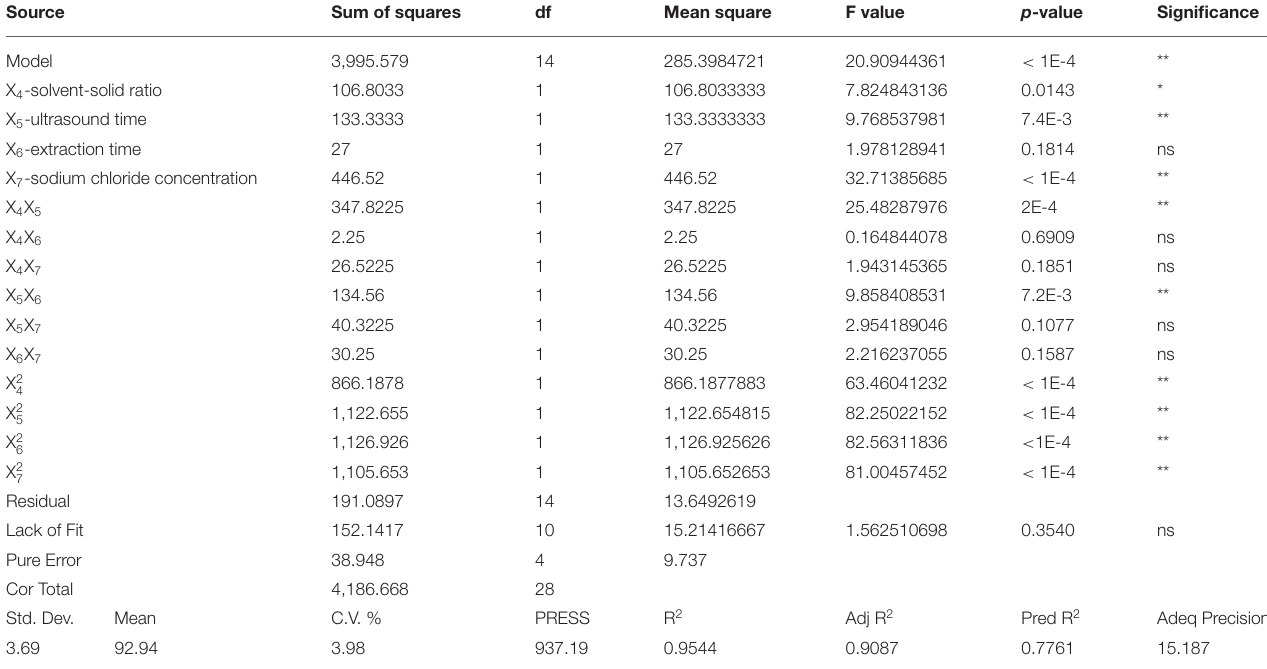
TABLE 4 | The ANOVA of the fitting model of TCEO by ultrasound-assisted extraction.